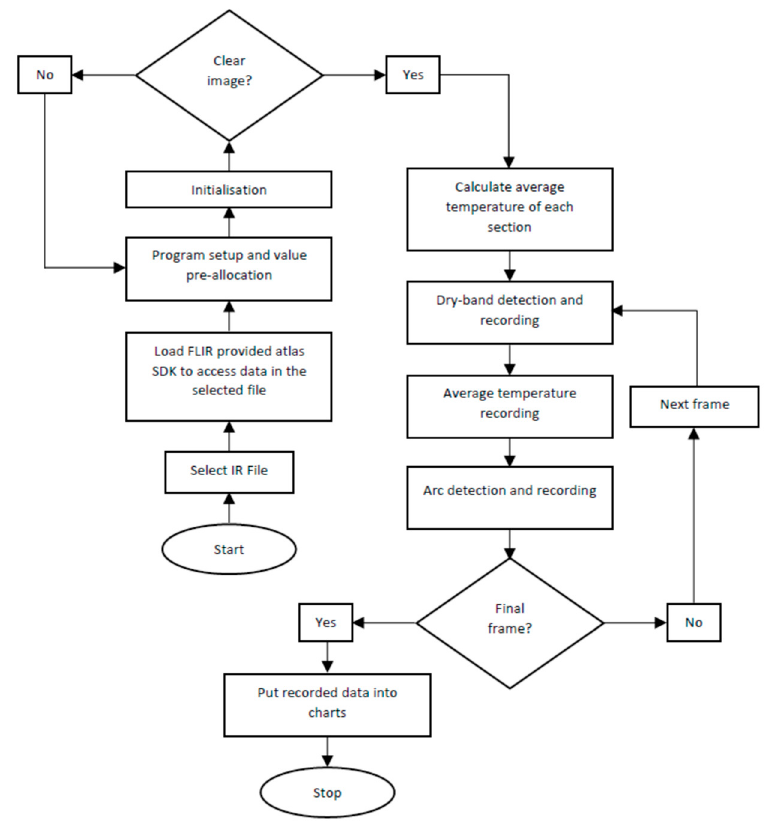
Figure 4. Schematic diagram of the procedure adopted.